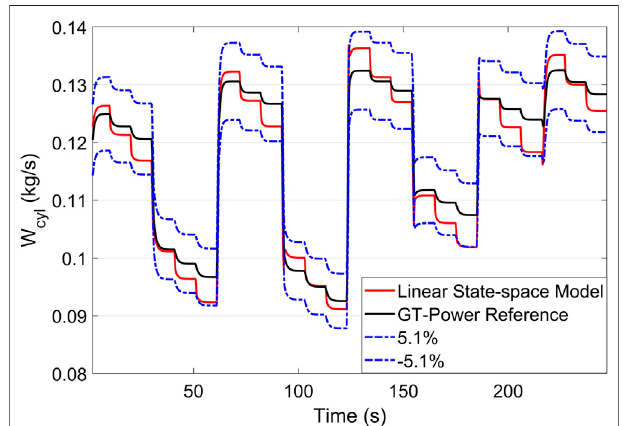
FIGURE 2 | Engine cylinder charge fl ow rate